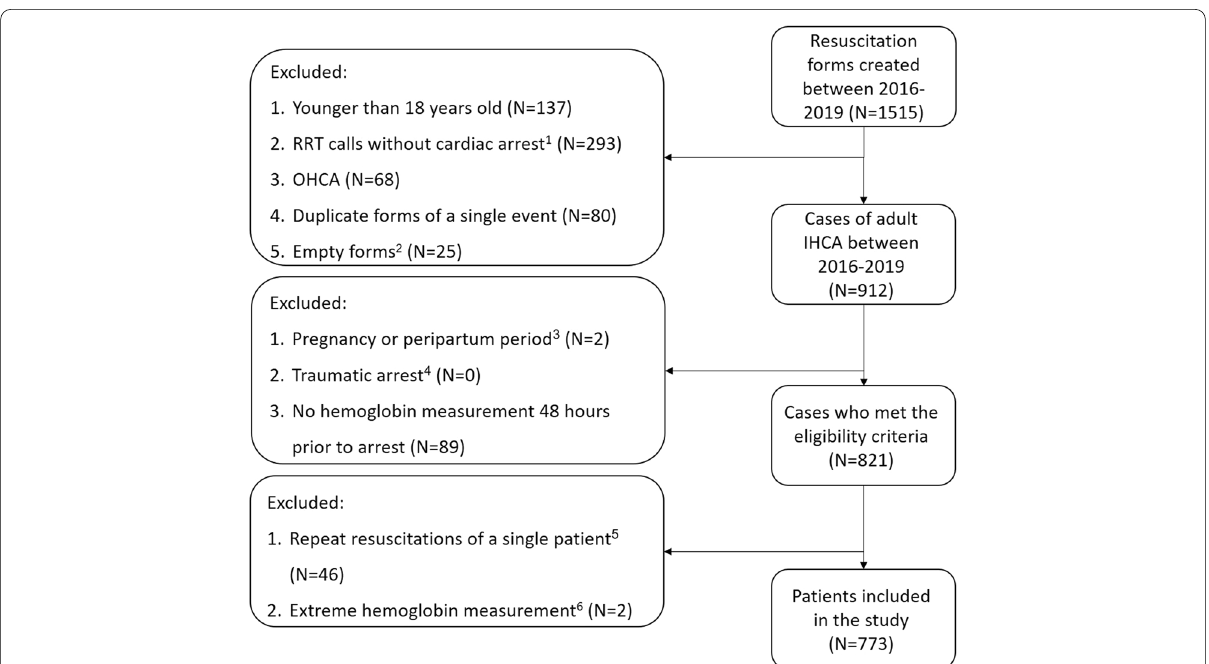
Fig. 1 Study inclusion exclusion flow chart. RRT rapid response team. OHCA out-of-hospital cardiac arrest. ROSC return of spontaneous circulation. 1 Ascertained either by manual evaluation or by a statement in the electronic form that cardiac arrest had not occurred and no evidence of chest compressions was found. 2 No information entered to the electronic form by the on-site medical team and therefore could not be verified. 3 Ascertained by excluding events reported from the delivery room, maternity wards, or department of gynecology. 4 Ascertained by manual review of cases reported from the ED, general surgery, operating theatre, postoperative care unit, or any location in the imaging. 5 In case of repeat resuscitations of a single patient, only the first arrest was included. 6 Hemoglobin measurements lower than 4 g/dL or higher than 20